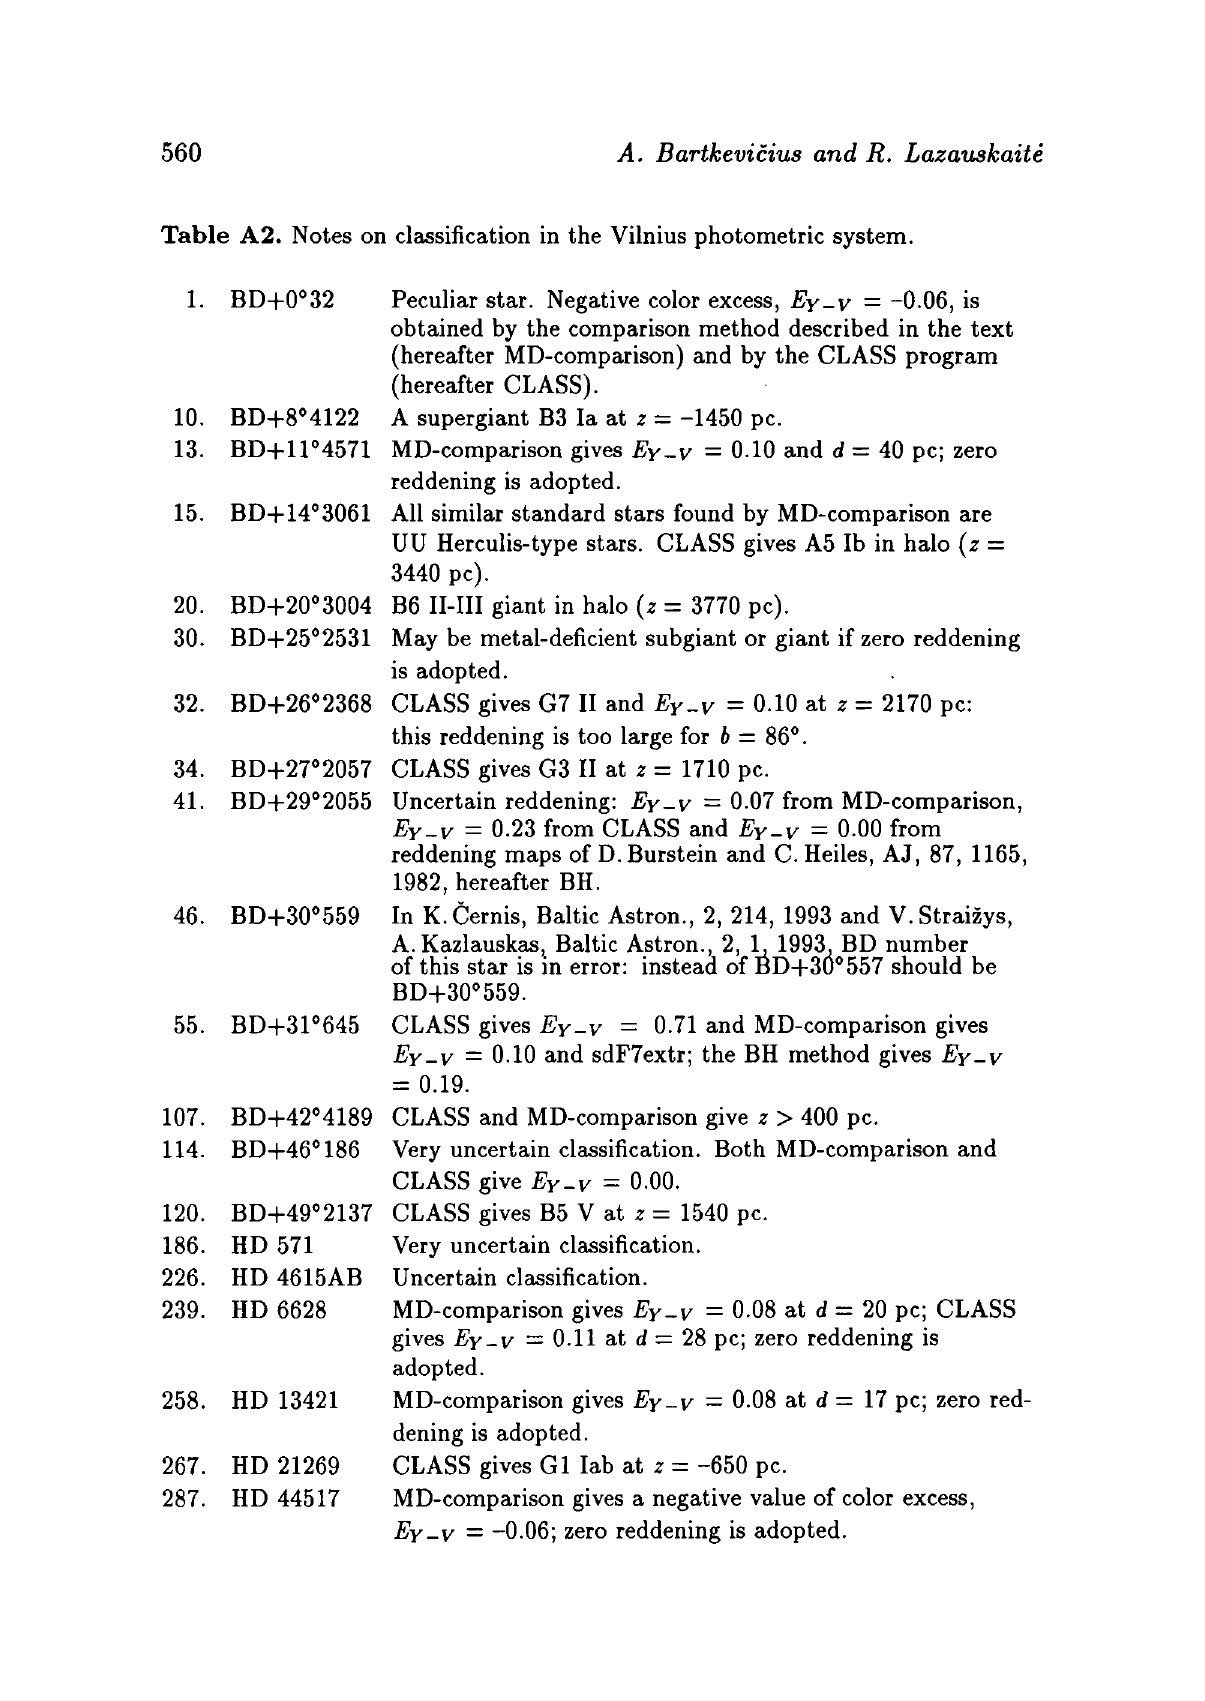
Table A2. Notes on classification in the Vilnius photometric